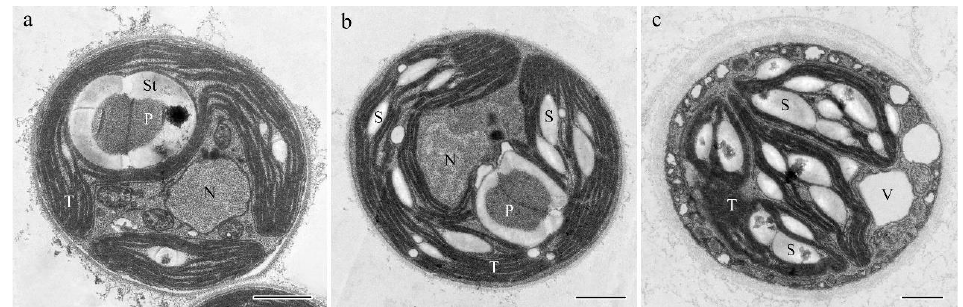
Figure 5. Transmission electron microscopy of P. kessleri FACHB-3316: ( a ) 0.036 g/L; ( b ) 3.6 g/L; ( c ) 36 g/L. (T = thylakoids, N = nucleus, P = pyrenoid, S = starch grains, St = starch sheath; V = vacuole, Scale bar 1μm).